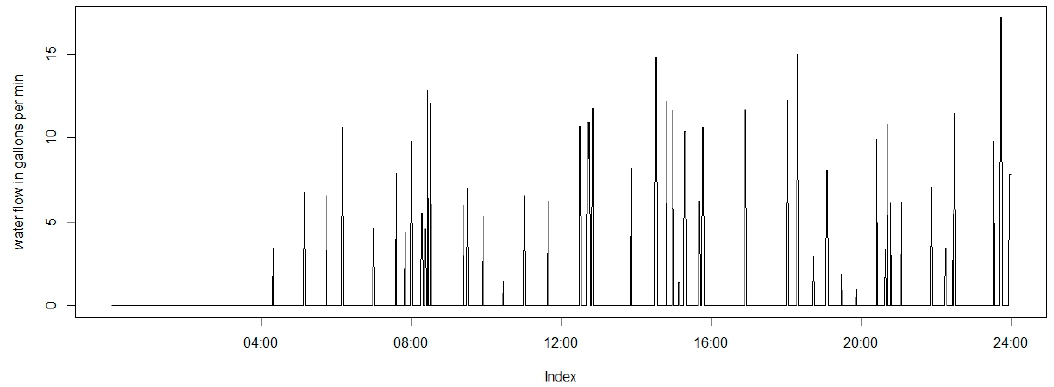
Figure 2. One-minute averaged flow over a full day. Table 1. Average flow and average volume for the most common water usages and water